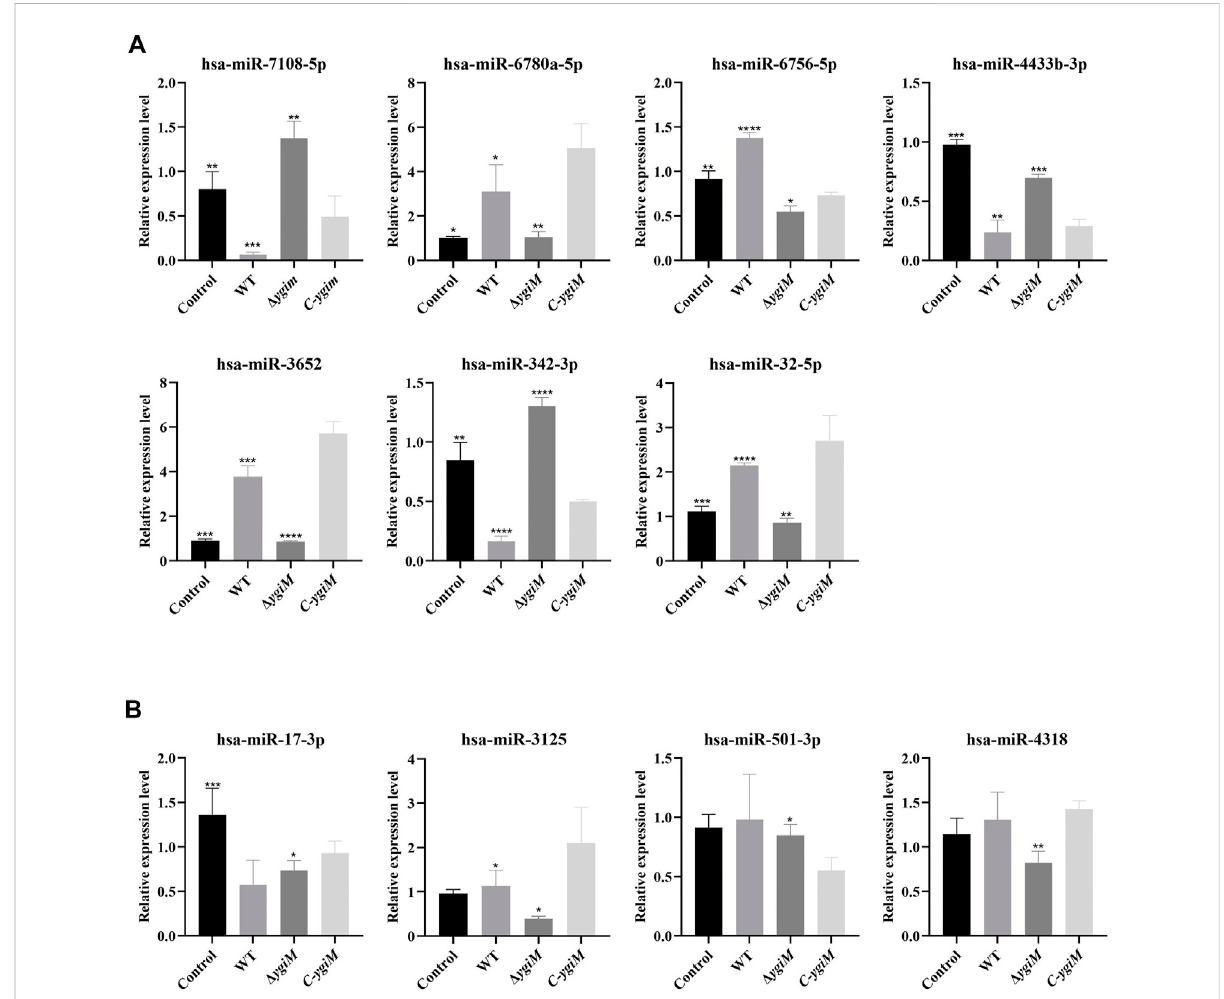
The relative expression of miRNA in K. pneumoniae wild-type, Δ ygiM and C-ygiM strains. (A) Positive targets of miRNA: hsa-miR-7108-5p, hsa- miR-6780a-5p, hsa-miR-6756-5p, hsa-miR-4433b-3p, hsa-miR-3652, hsa-miR-342-3p and hsa-miR-32-5p were considered to be statistically signi fi cant in the infection of K. pneumoniae control, wild type and Δ ygiM groups (*: p < 0.05, **: p < 0.01, ***, p < 0.001: ****: p < 0.0001). (B) NegativetargetofmicRNA:hsa-miR-501-3p,hsa-miR-17-3p,hsa-miR-3125andhsa-miR-4318wereconsideredtobestatisticallyinsigni fi cant in the infection of K. pneumoniae control, wild type and Δ ygiM groups (*: p < 0.05, **: p < 0.01, ***: p <